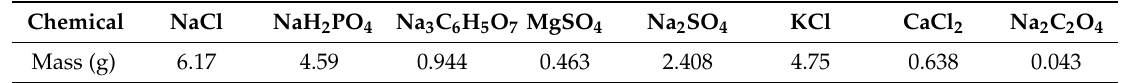
Table 1. Artificial urine composition